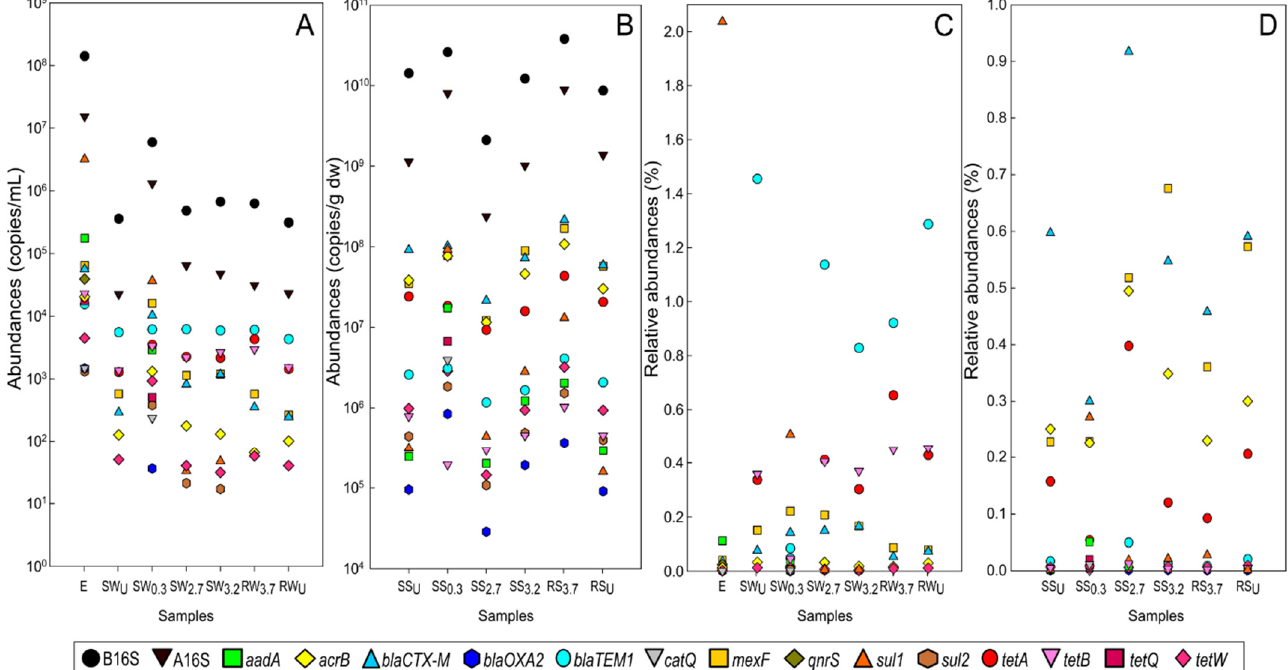
Figure 1. The abundances of bacterial and archaeal 16S rRNA genes (B16S and A16S, respectively) and antibiotic resistance genes (ARGs) and relative abundances of ARGs in the water ( A , C ) and sediment samples ( B , D ). E is the effluent of the wastewater treatment plant (WWTP), SW and RW are water samples and SS and RS are sediment samples of the stream and river, respectively. SW U and SS U are the samples taken upstream of the WWTP discharge point, and RW U and RS U are the samples taken from the river upstream of the stream inflow point. The number in the subscript of the sample code shows the distance (km) of the sampling point downstream from the WWTP discharge point.